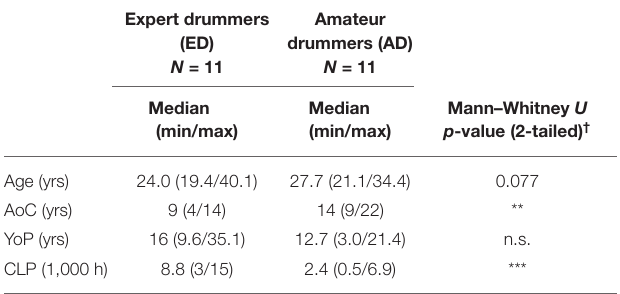
TABLE 1 | † Alpha levels for significance were predetermined at 0.05 (significant, *), 0.01, and 0.001 (highly significant, ** and ***, respectively). Expert drummers